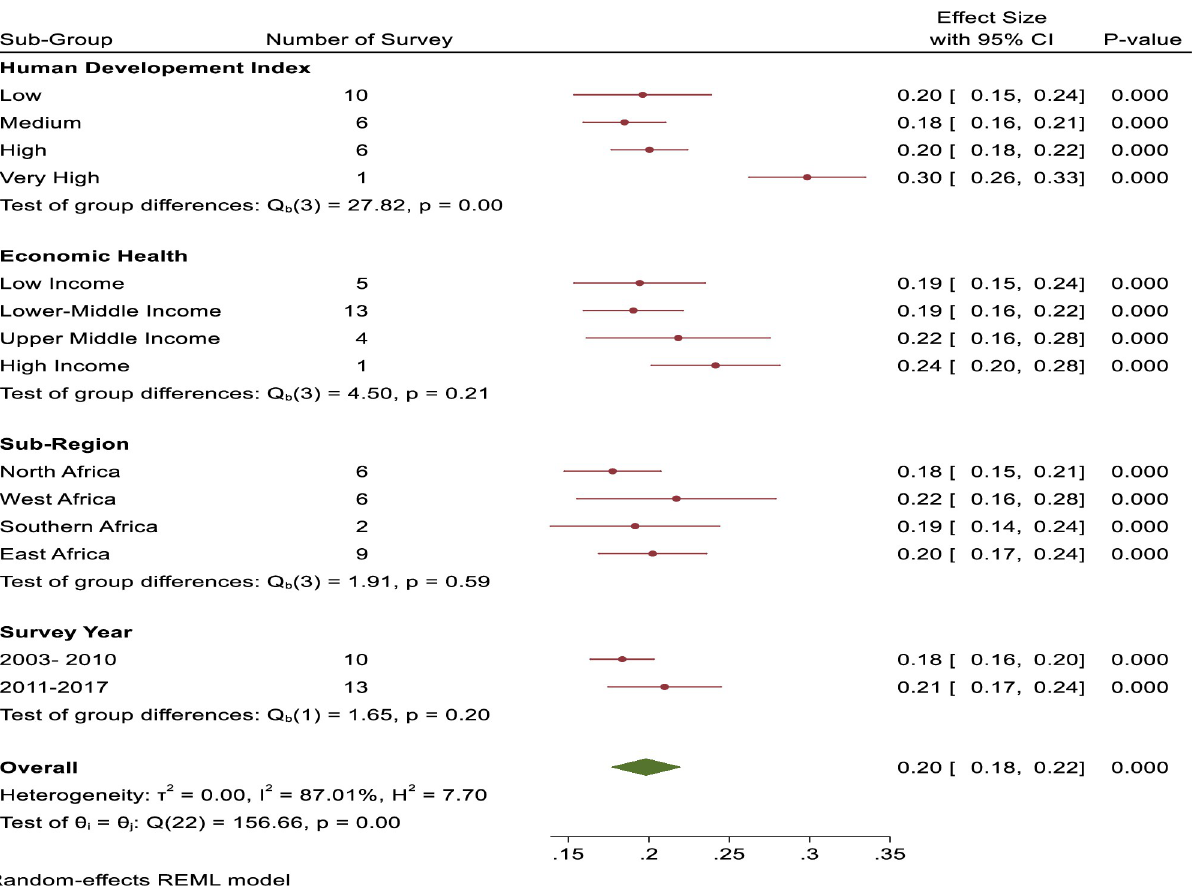
Fig 4. Sub- group analysis for adolescent sufficient physical activity level with respect to HDI, economic health, sub-region and the survey years.